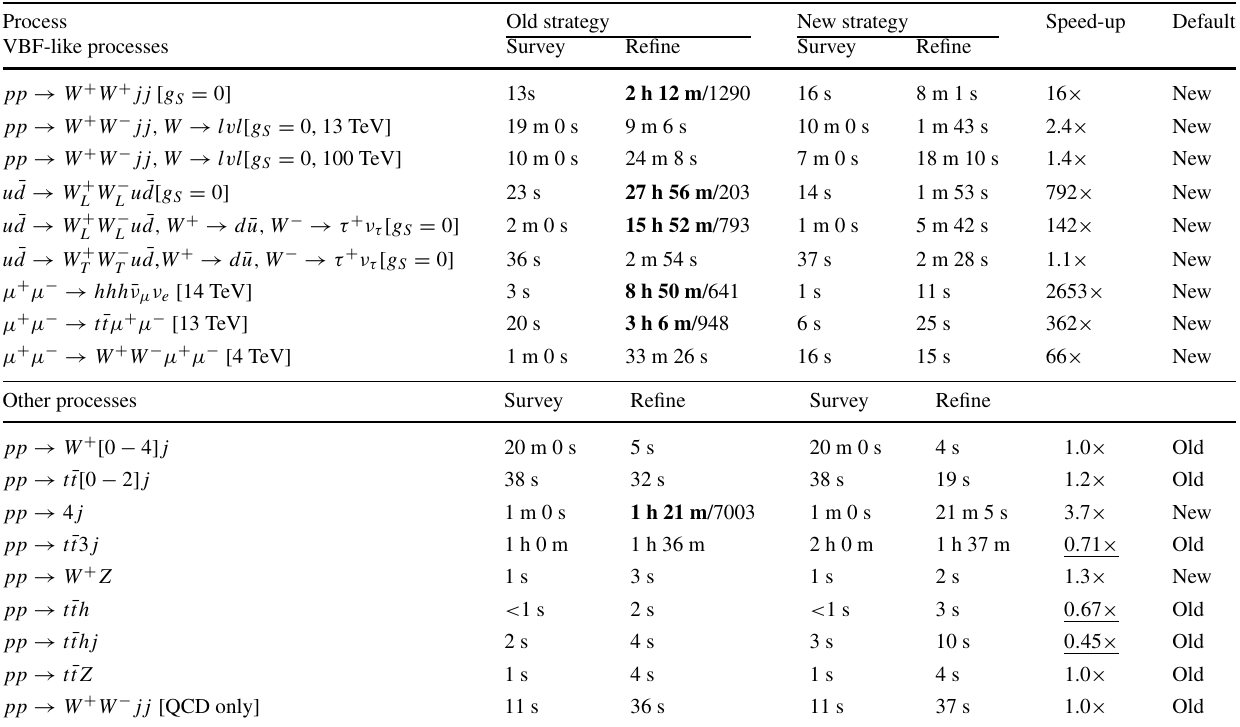
Table 6 Integration timing (time to solution) on a mac-book pro (quad- core 2016) to generate 10k events depending of the multi-channel strat- egy. If the generation fails to generate enough events the timing is re-